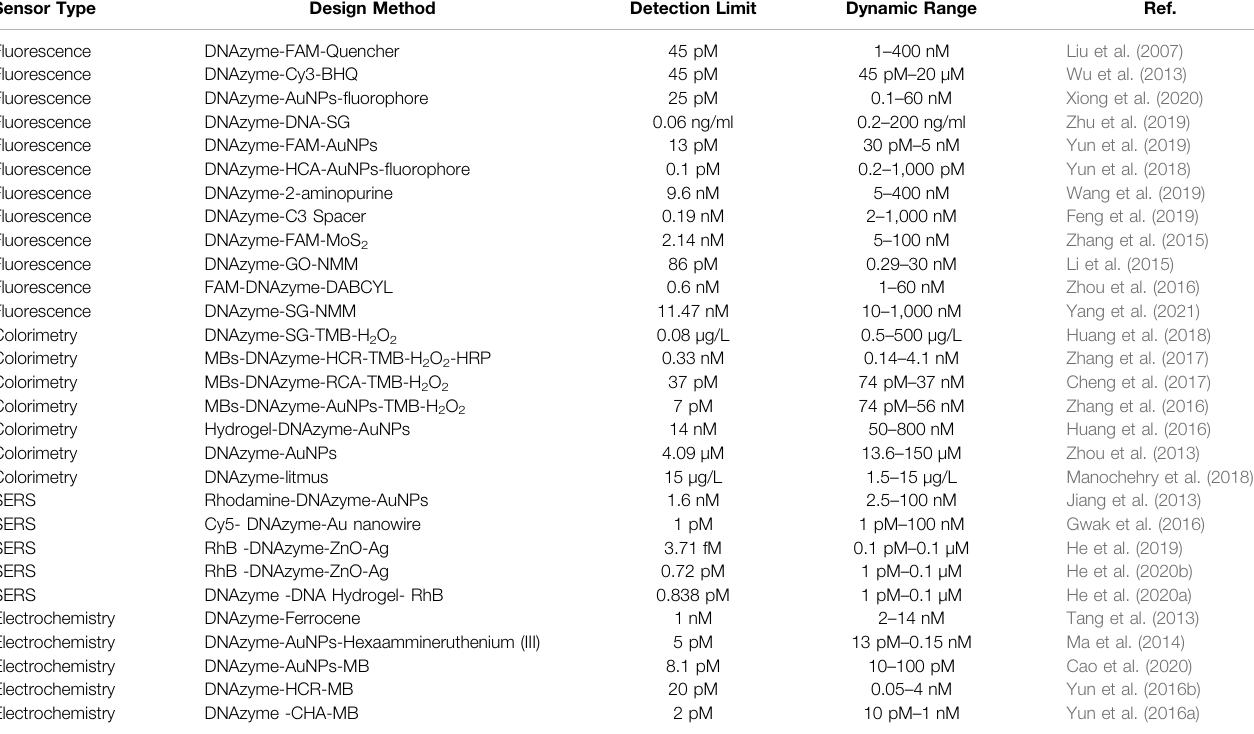
TABLE 1 | DNAzyme-based biosensors for the detection of uranyl ion. Sensor